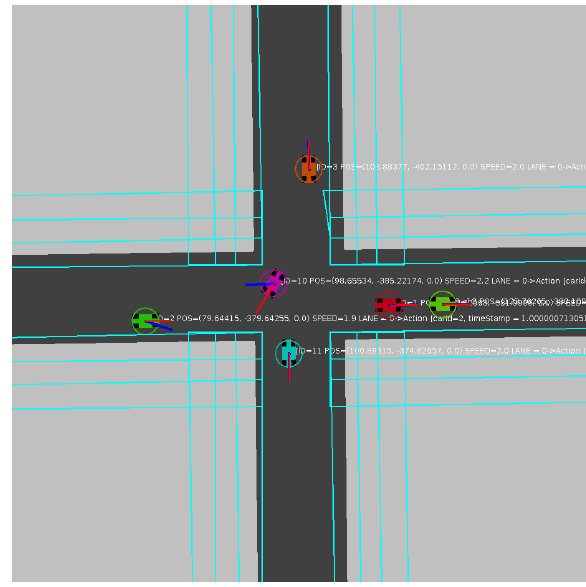
Figure 4. Visualization of junction passing using the ORCA